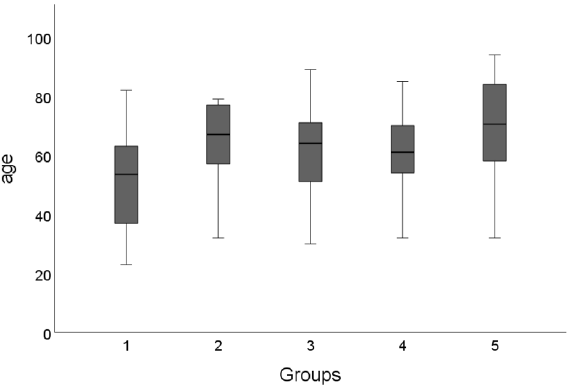
Figure 1. Boxplot of age and severity of COVID-19. The age distribution of the five groups. The median, upper quartile, lower quartile, minimum and maximum are